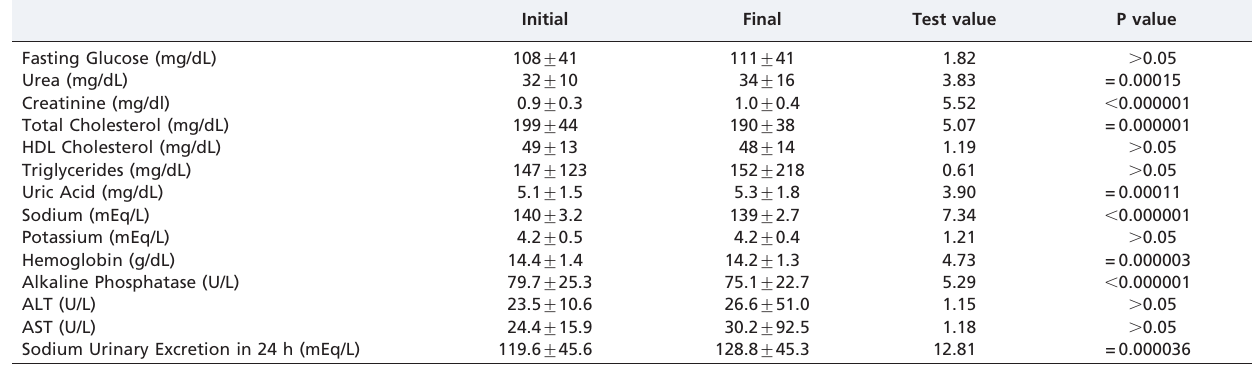
Table 6 - Results of laboratory tests measured at the beginning and end of the